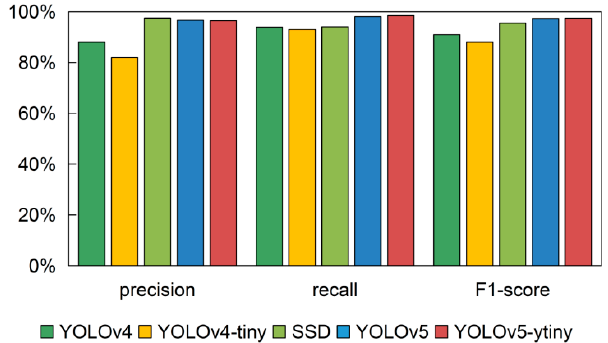
Figure 10. Comparison of various algorithm evaluation indicators.